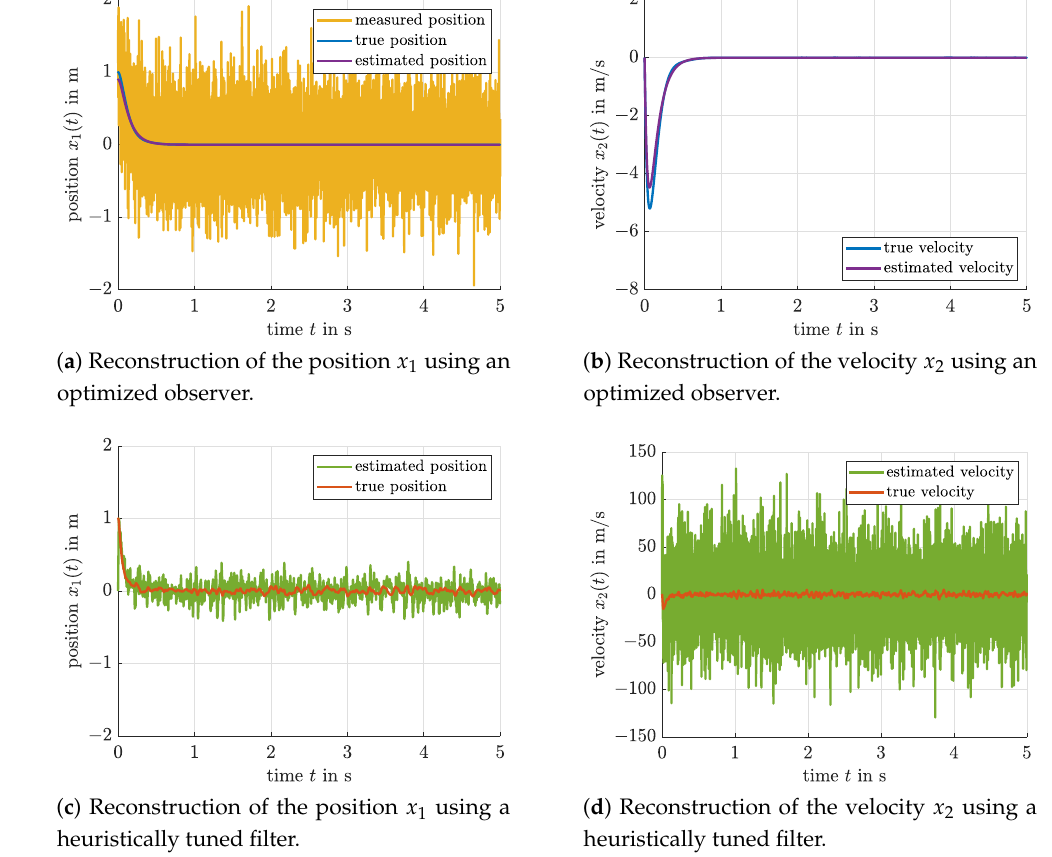
Figure 8. Comparison of a heuristic D-type control approach with an optimized observer from the previous work [26]